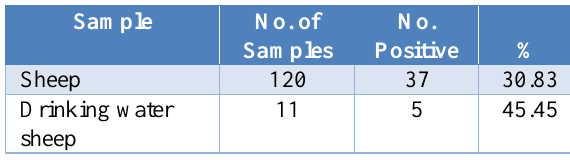
Table, 1: Total rate of infection with B.sulcata in sheep and drinking water.